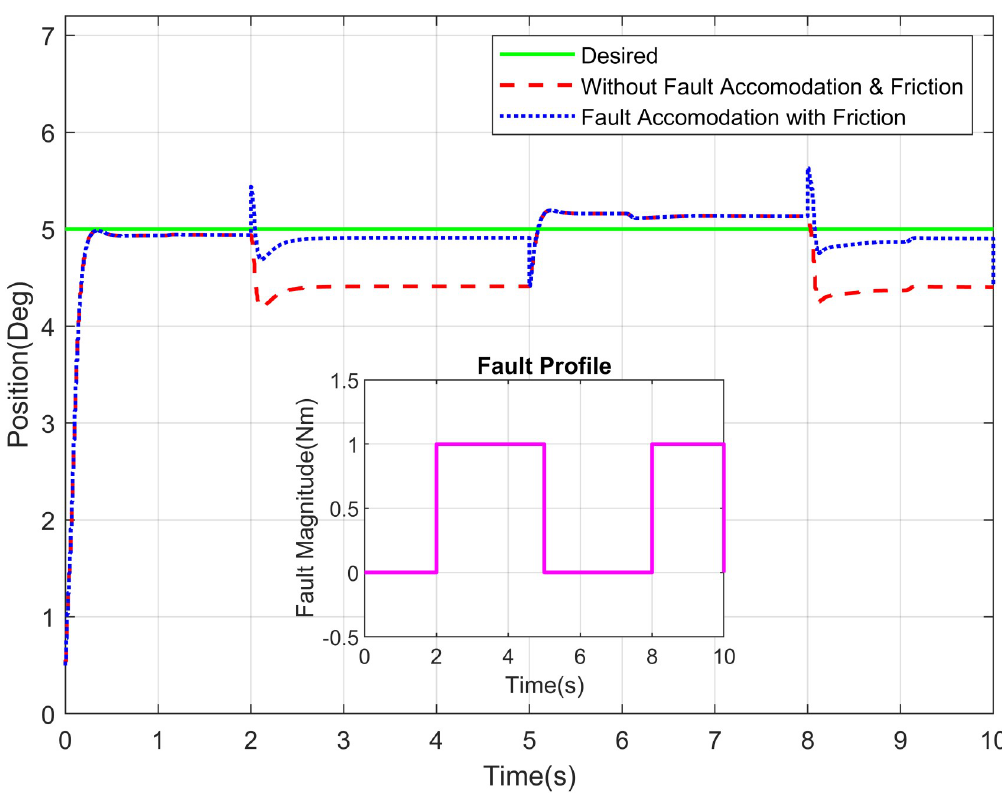
Fig 18. Position tracking of shoulder joint of a robot manipulator with intermittent fault